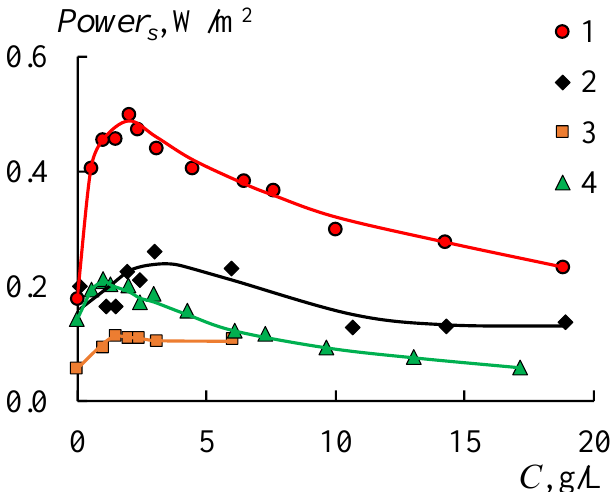
Figure 17. Influence of diluted solution concentration on power density for different membrane stacks with the initial smooth MK-40 and MA-41 membranes (1), the profiled MK-40_3P and MA- 41_3P membranes (2), the profiled bilayer MK-40_3PM and MA-41_3PM membranes (3), the profiled modified MK-40_3PM and the initial smooth MA-41 membranes (4).